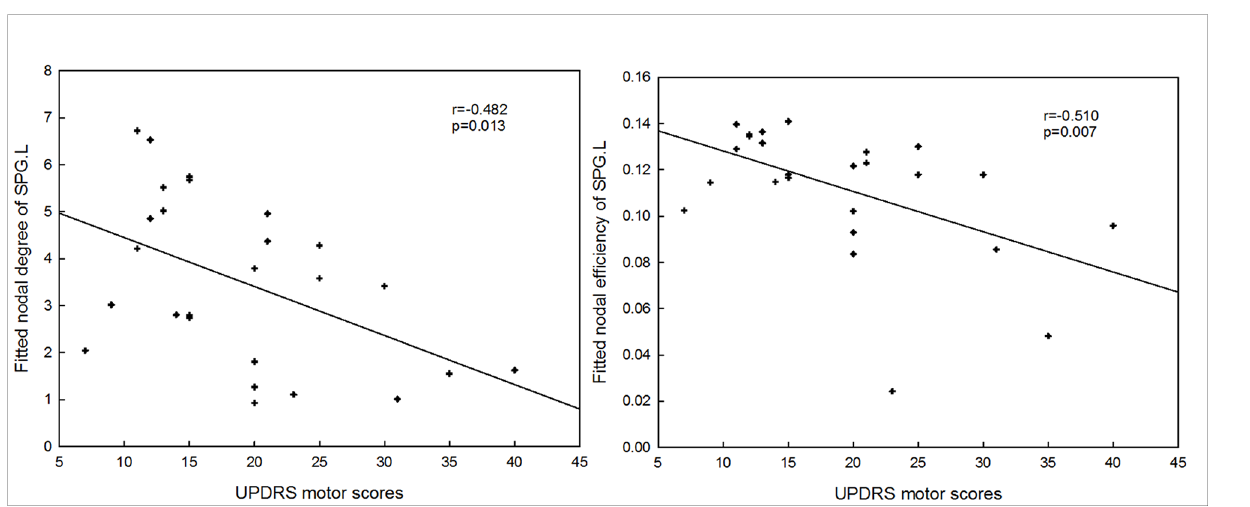
Fig 6. Correlation between abnormal network properties and UPDRS motor scores. SPG.L: the left superior parietal gyrus.